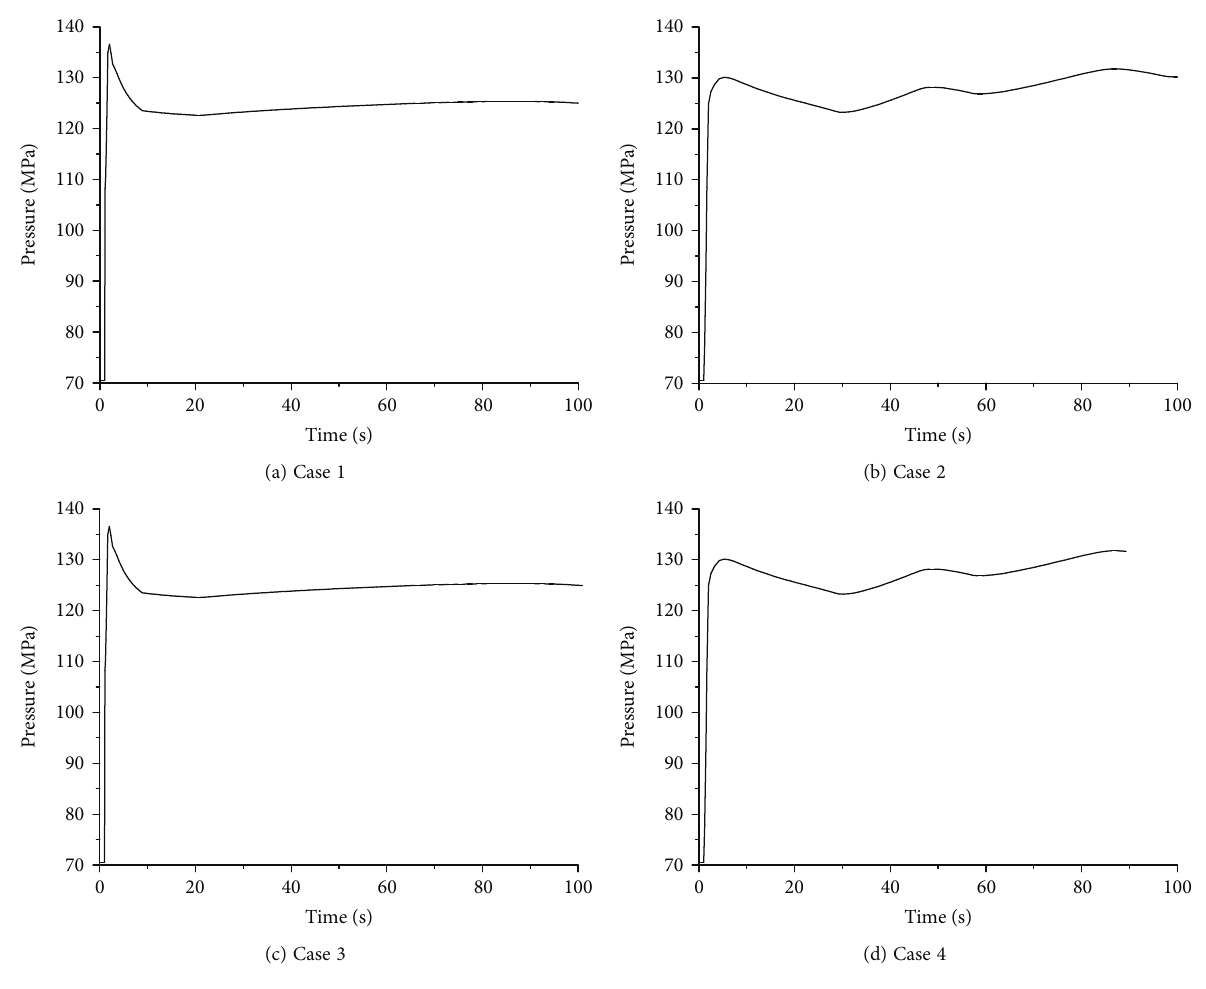
Figure 6: Injection pressure within the fracture in Cases 1, 2, 3, and